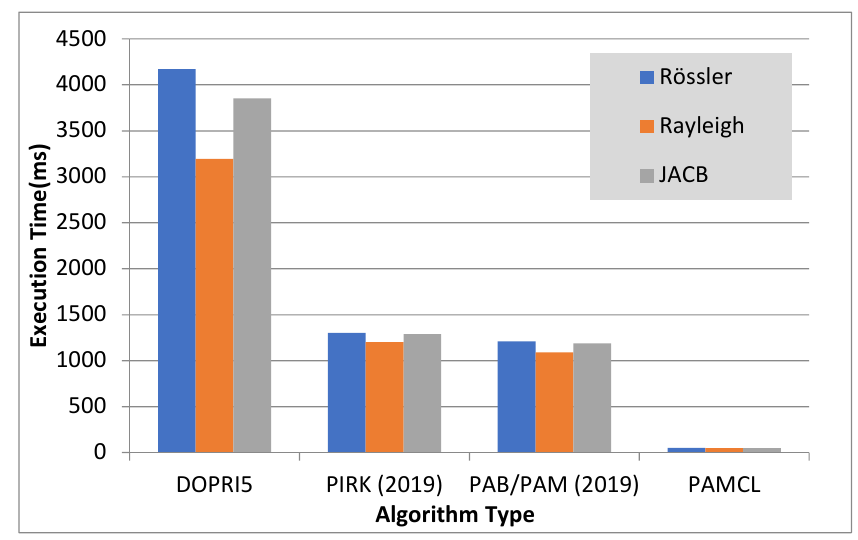
Figure 5. Comparison of the execution times of different problems while using different algorithms. The maximum computation error to stop the computing process is 0.001. All algorithms are executed on GPU for solving the Rössler equation. DOPRI5 , PIRK, PAB/PAM and PAMCL are using 1, 8, 16 and 500 GPUs.